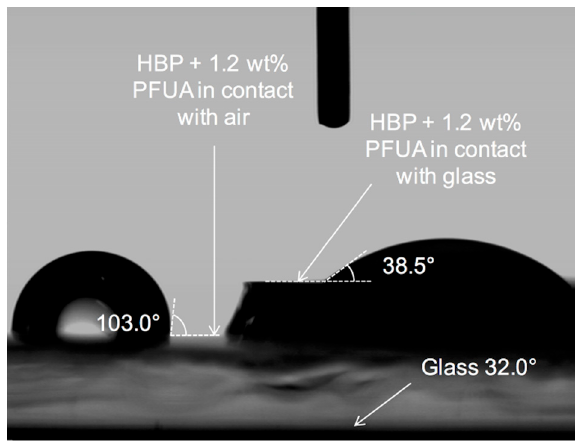
Figure 6. Morphology of water droplets on HBP with surface segregated PFUA in contact with air ( left droplet) and with glass ( right droplet) during UV curing.